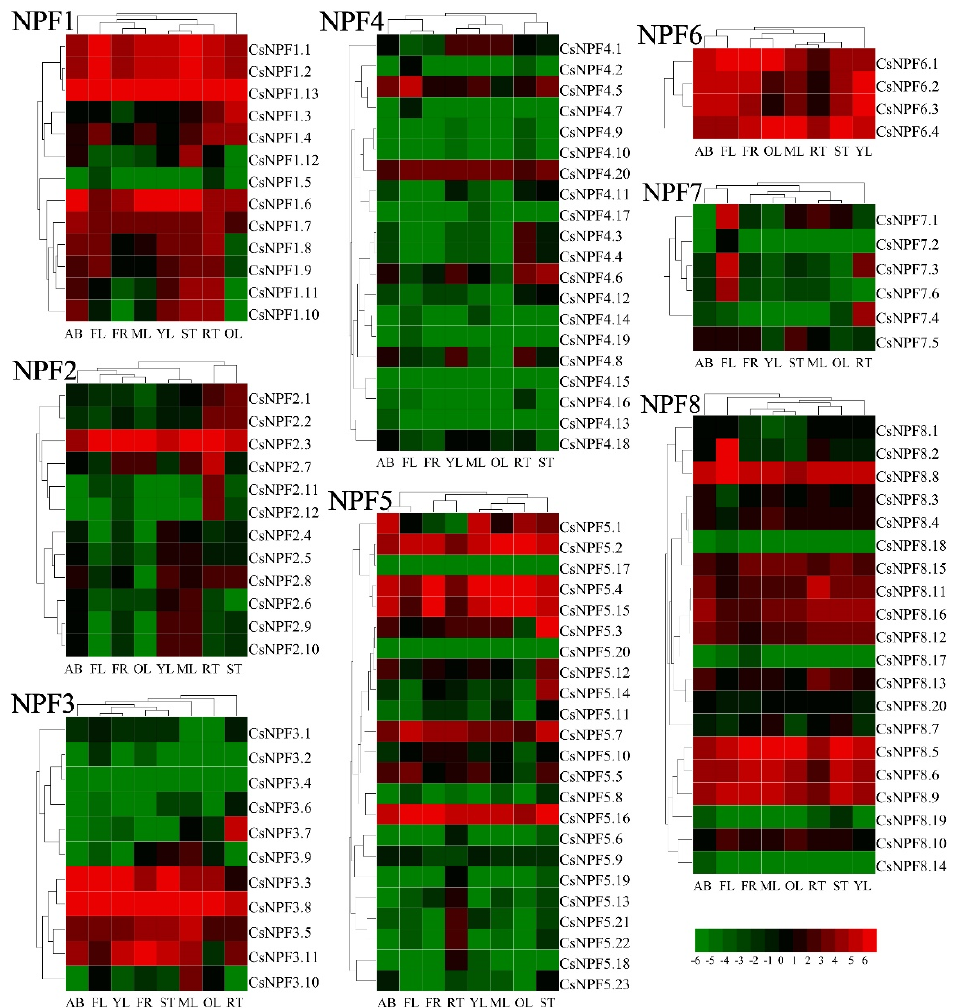
Figure 9. Expression heatmap of CsNPF genes in 8 tissues of tea plant. The tissues are apical buds (AB), young leaves (YL), mature leaves (ML), old leaves (OL), young stems (ST), flowers (FL), young fruits (FR), and tender roots (RT). Gene expression level was evaluated log2 transformed RPKM value. Red represents high expression. Green indicates low expression.